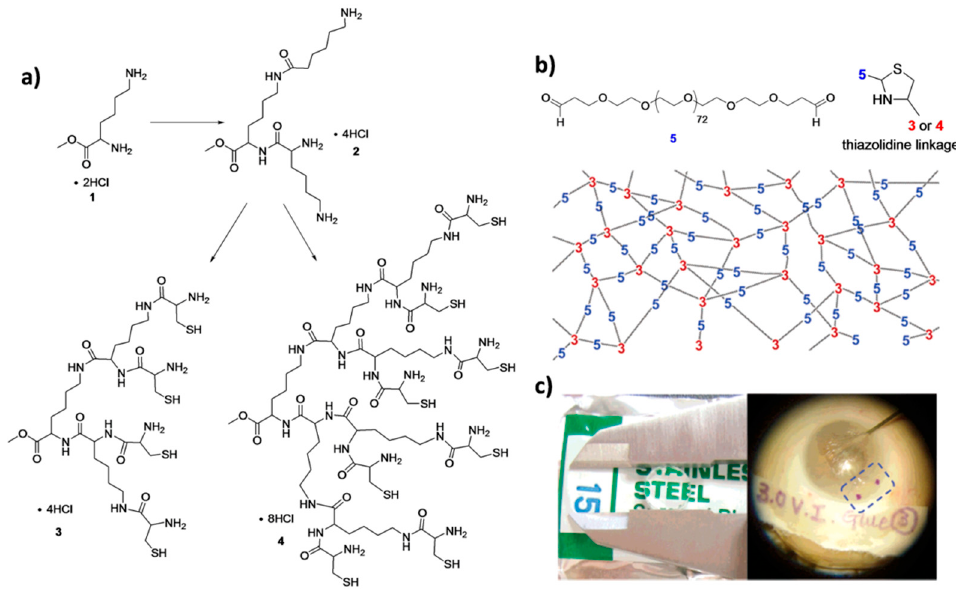
Figure 7. ( a ) Synthesis of peptide dendrons; ( b ) structure of macromers and the thiazolidine linkage; ( c ) synthesized hydrogel (left) and hydrogel sealant-repaired corneal incision. Adapted with permission from [22], Copyright © 2004 American Chemical Society.